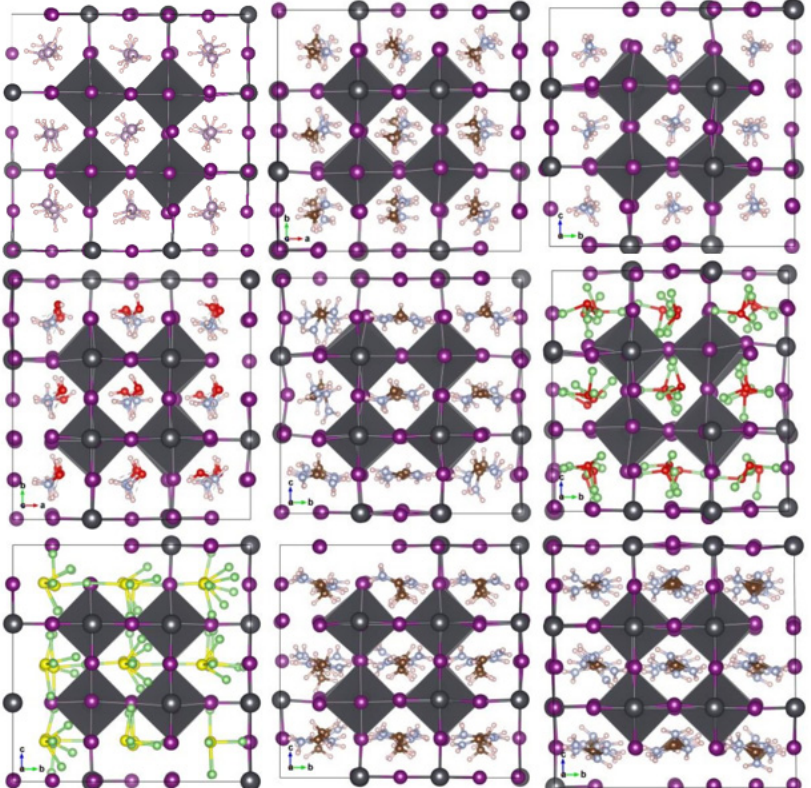
Figure 5. The cubic APbI 3 perovskites’ structure changed with a 3 × 3 × 3 supercell after ab initio molecular dynamics simulation of 50 ps at 300 K. Atomic colors are: Pb (grey); C (brown); H (white); F (blue); Li (cyan); Cl (green); N (silver); O (red); S (yellow); P (lavender); and I (purple).